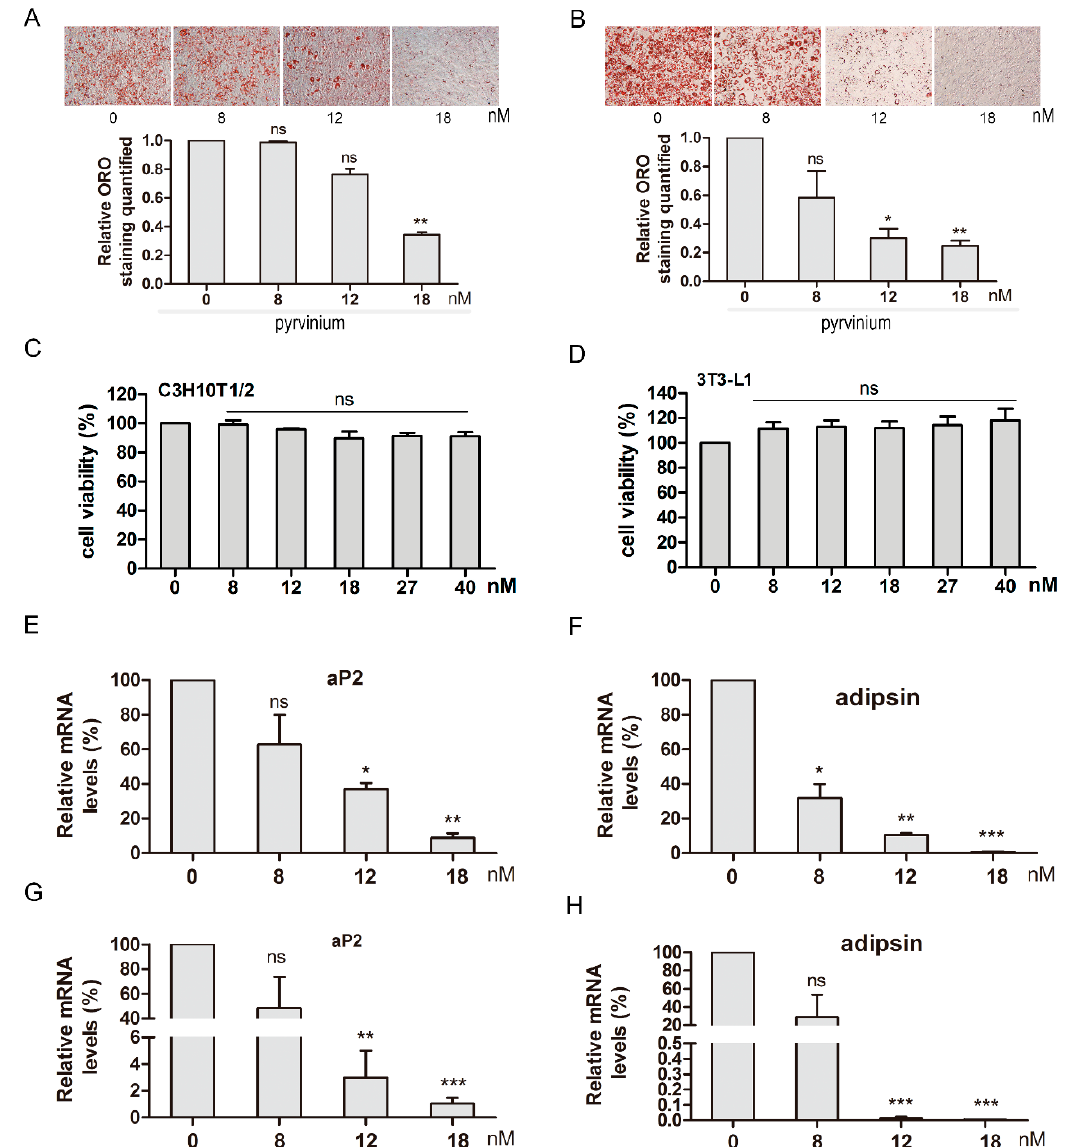
Figure 2. Pyrvinium inhibits adipocyte differentiation of C3H10T1/2 and 3T3-L1 cells. The Oil Red O (ORO) staining and relative quantification analysis at 8 days for adipogenic induction ( A . C3H10T1/2, B . 3T3-L1). The cell viability analysis after pyrvinium treatment for 48h ( C . C3H10T1/2, D . 3T3-L1). The mRNA expression of adipogenic marker aP2 and adipsin after pyrvinium treatment ( E and F . C3H10T1/2, G and H . 3T3-L1). The data are presented as mean ± SEM from three independent experiments . ( ∗ P < 0.05, ∗∗ P < 0.01, ∗∗∗ P < 0.001 compared with 0 nM).